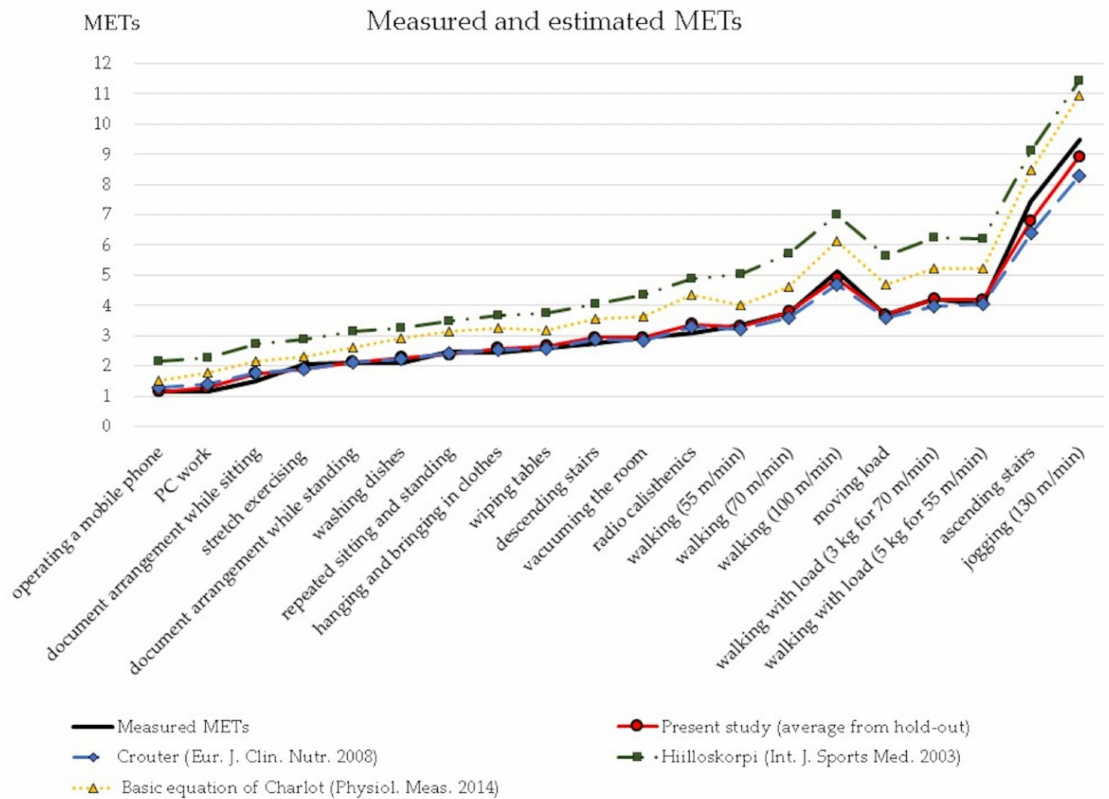
Figure 5. Measured and estimated METs of previous studies and present